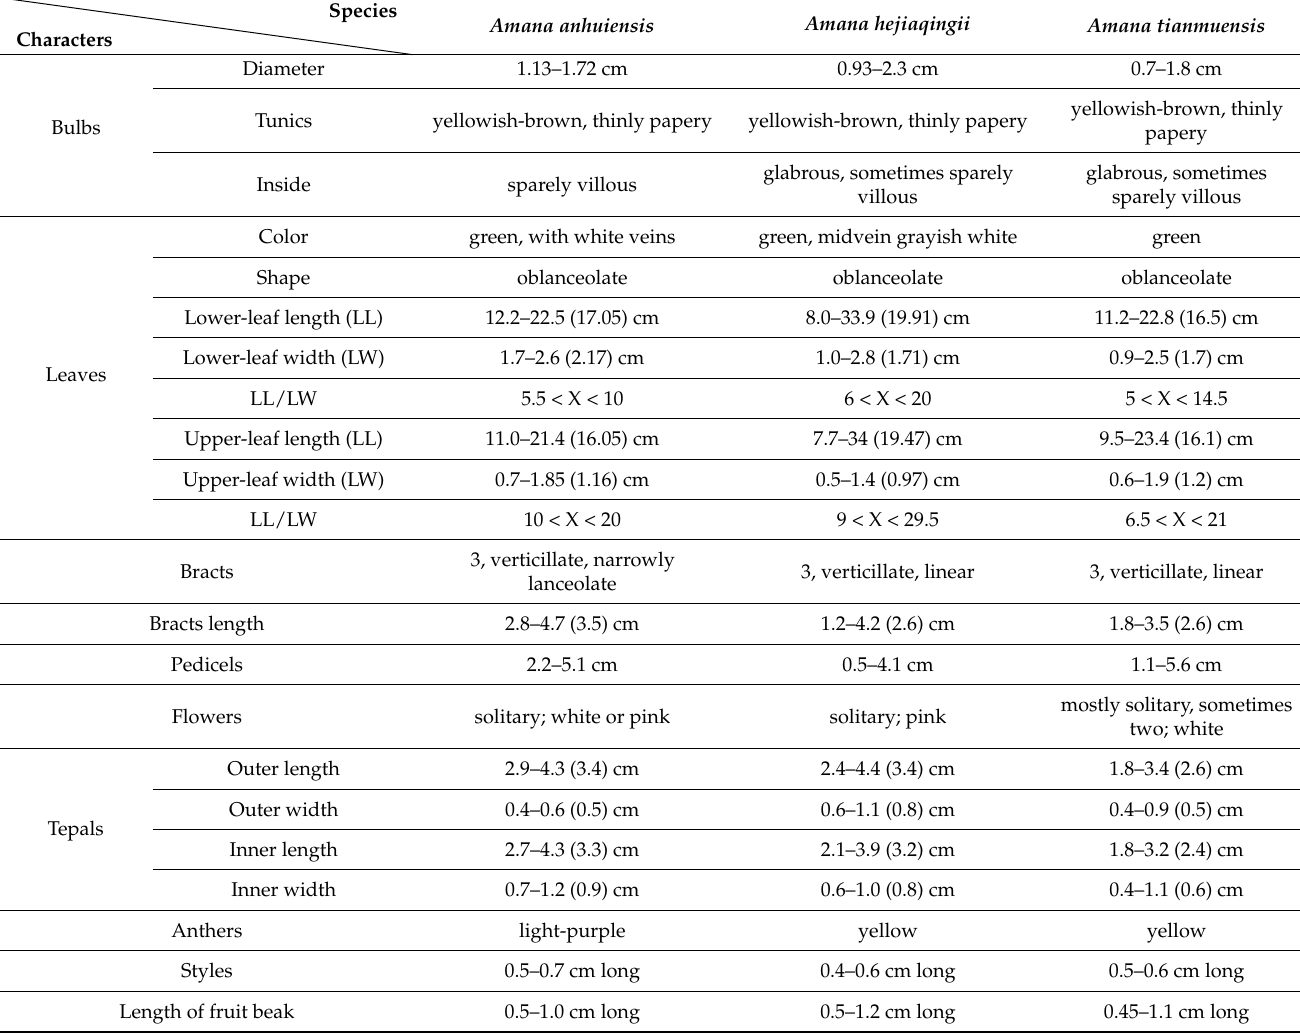
Table 2. Comparison of characteristics between Amana anhuiensis , Amana hejiaqingii and Amana tianmuensis (values in parentheses are